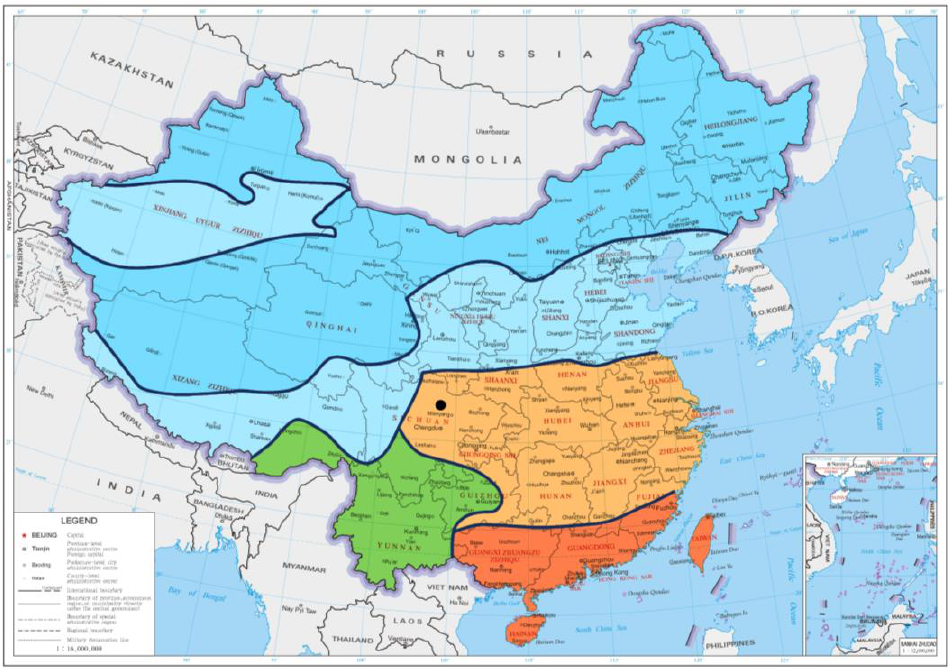
Figure 1. The climate classification for building design in China and the location of Mianyang, Draft Approval No GS (2019)1694 [33].